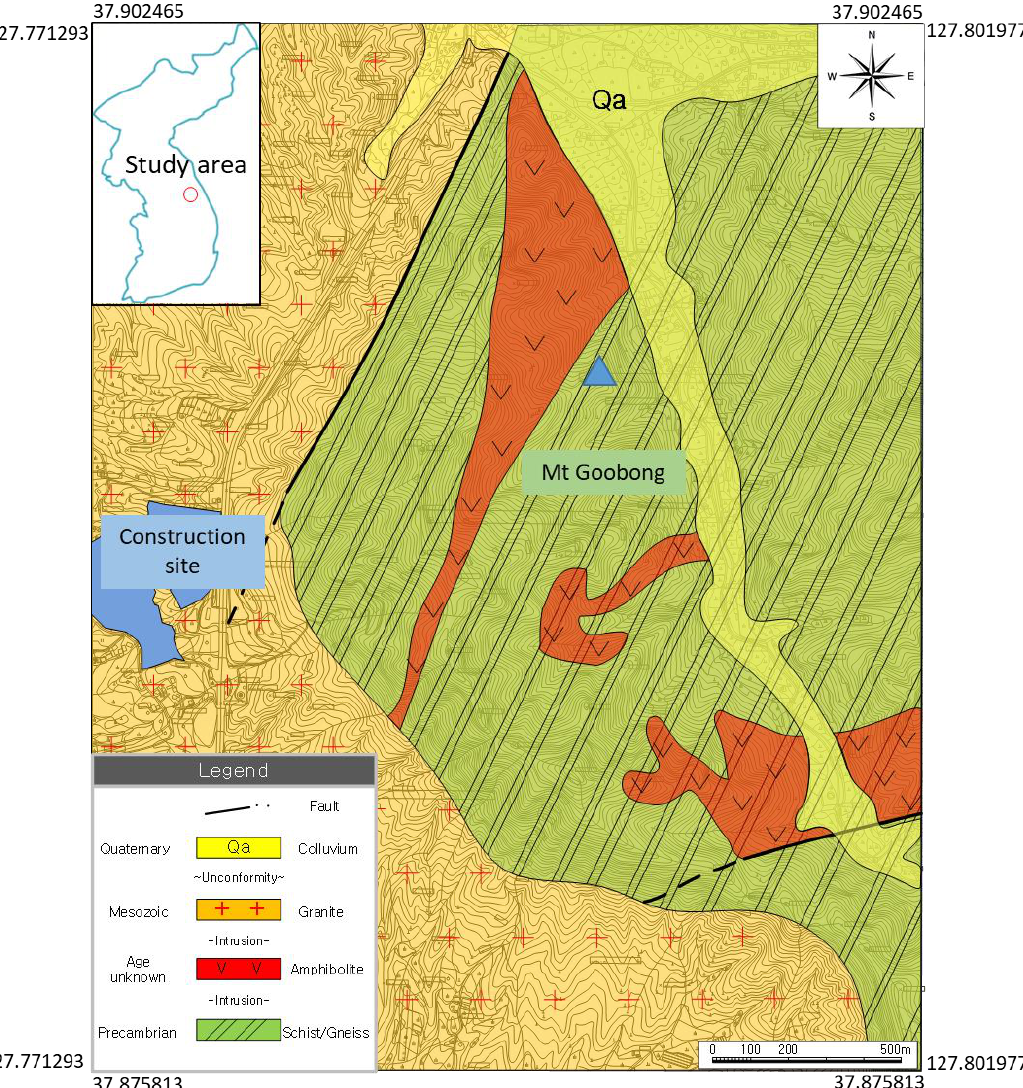
Figure 1. Geological map of the study area.